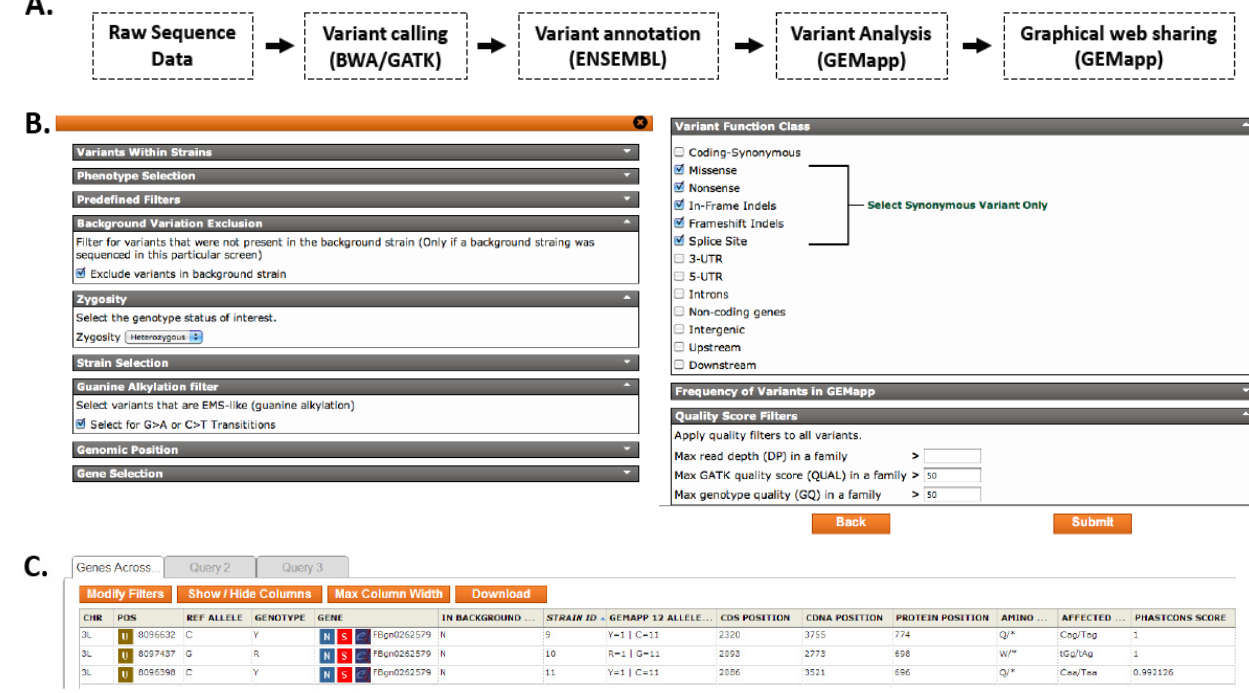
Figure 4. GEM.app bioinformatics pipeline and online graphical interface. (A) The systematic processes of the automated GEM.app bioinformatics pipeline. (B) Screenshot of the GEM.app form with some of the filtering options displayed. (C) The output of GEM.app query used to identify ect4 mutations. A subset of 34 total columns are shown. Links within the table (U, N, S, e) provide direct access to common resources, such as UCSC genome browser, NCBI, String gene networks, and Ensembl. Up to three tabs allow for parallel queries. Additional options include modifying filter settings, managing columns, and downloading results in an excel